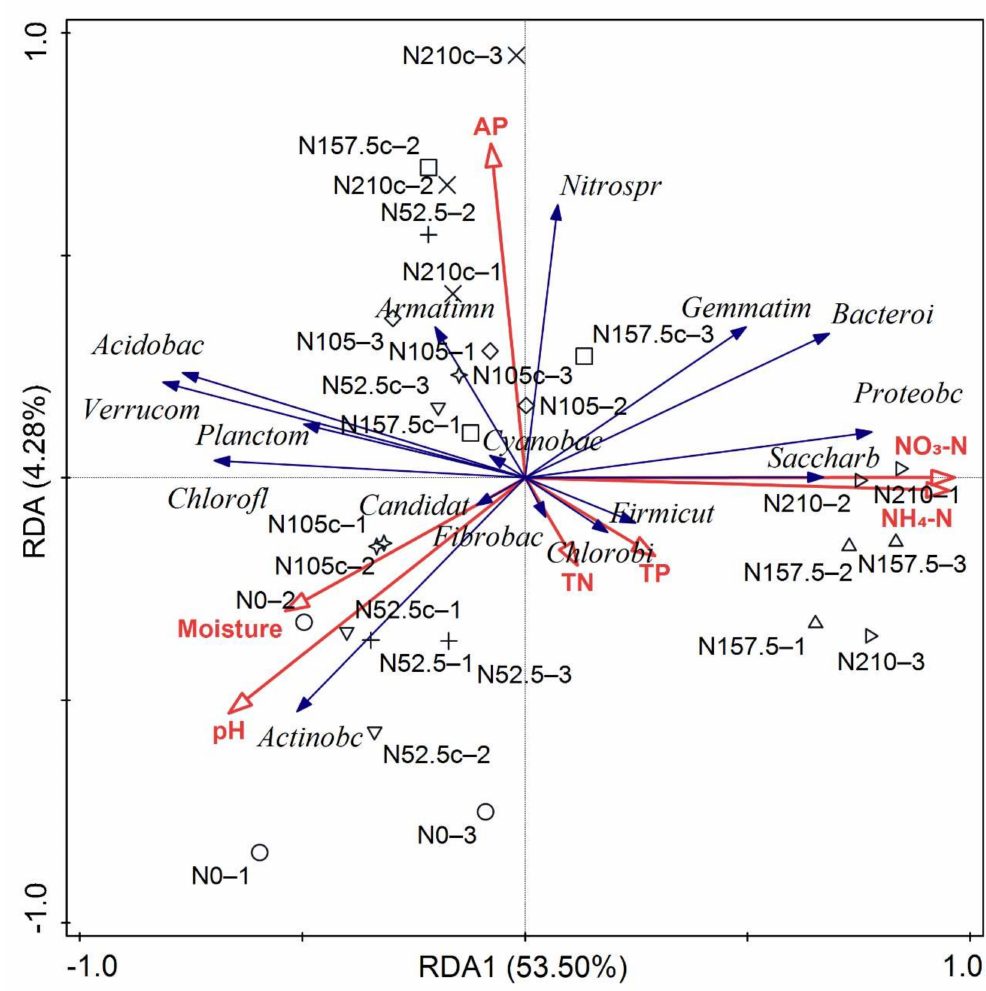
Figure 6. Summary of redundancy analysis (RDA) of the soil bacterial phyla. pH, soil pH; TN, soil total nitrogen; TP, soil total phosphorus; AP, soil available phosphorus. N0, 0 kg N ha − 1 year − 1 ; N52.5,